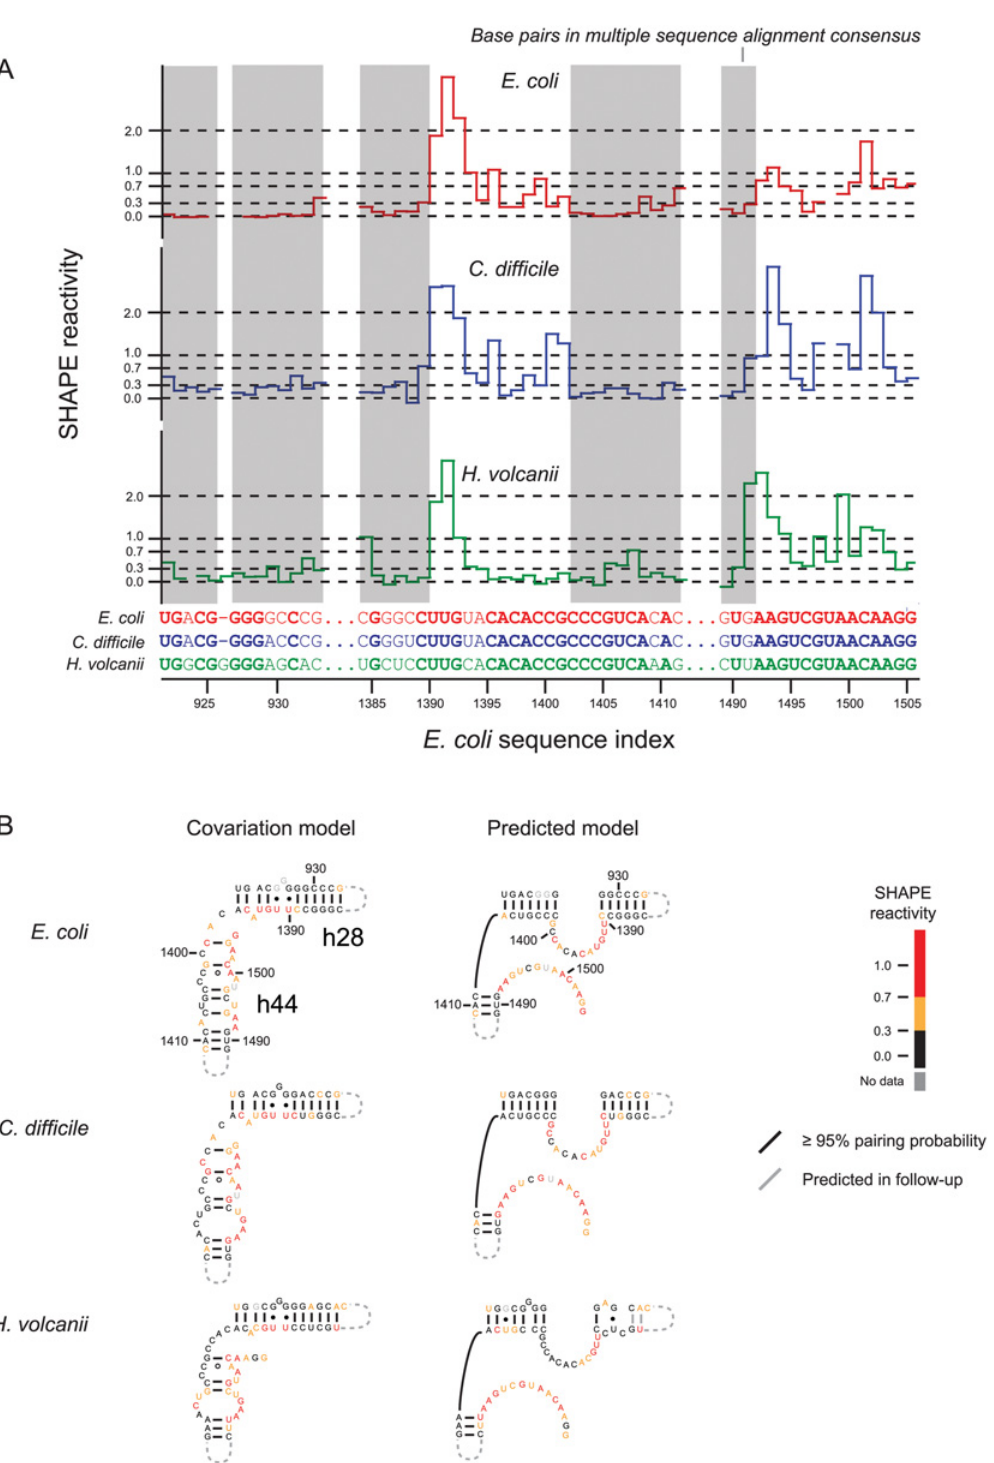
Fig 5. Consensus alternate structures in the decoding site. Helices 28 and 44 of the E. coli 16S rRNA are shown. ( A ) SHAPE reactivities for aligned regions. Consensus base pairs are highlighted in gray. ( B ) Structures for the covariation and SHAPE-structure constrained models. Base pairs in the RNAalifold consensus are shown in black, and base pairs predicted in the follow-up constrained RNAfold prediction are gray.